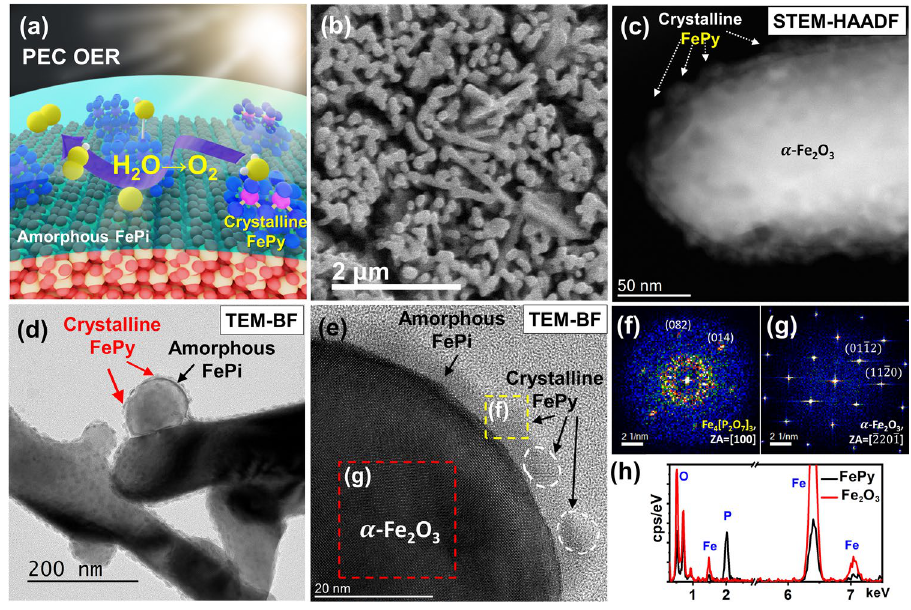
Fig. 1 a Schematic illustration. b SEM image. c HAADF‑STEM image. d, e TEM‑BF images of FePy@FePi decorated nanorods. f, g FFT obtained from e . h EDS elemental spectra obtained from f and